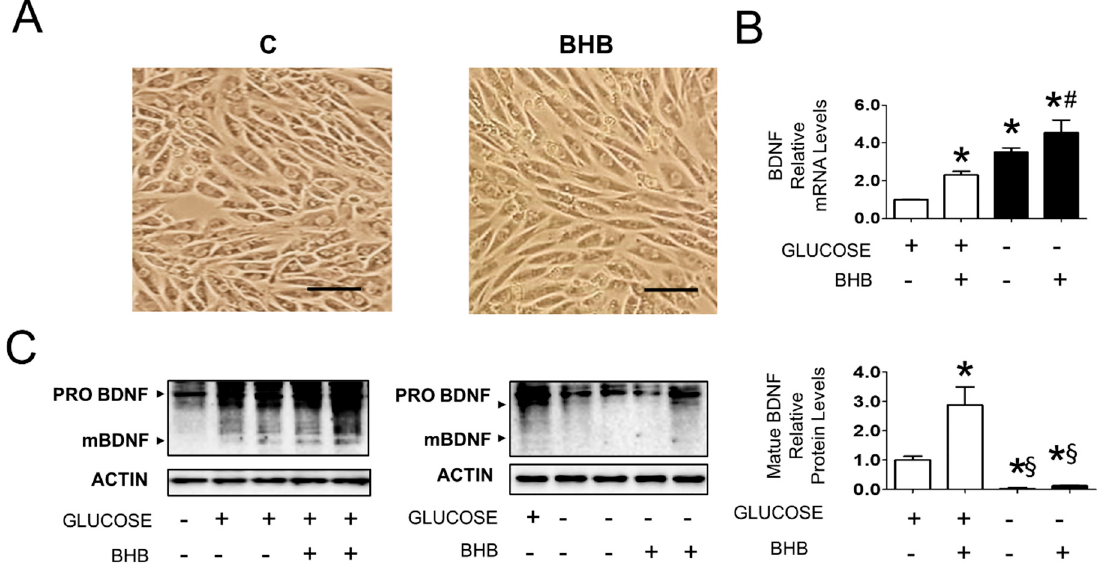
Figure 3. Effect of BHB on BDNF expression and maturation in L6 cells cultured in the presence and absence of 25 mM glucose ( N = 6). ( A ): Morphology of cells cultured in absence or presence of 8 mM BHB for 3 days. The images represent cells cultured in absence of glucose, similar results were observed in presence of glucose (not shown). Scale bar: 100 μ M. ( B ): BDNF mRNA levels in cells cultured in the presence and absence of 25 mM glucose and treated with solvent or 8 mM BHB. * p < 0.05 vs. control cells in presence of glucose, # p < 0.05 vs control cells in absence of glucose; ( C ): Protein levels of proBDNF and mBDNF in cells cultured in presence and absence of 25 mM glucose and treated with solvent or 8 mM BHB. * p < 0.05 vs control cells in presence of glucose, § p < 0.05 vs. cells in presence of glucose treated with solvent or 8 mM BHB. one way ANOVA was carried out followed by a Newman Keuls post-hoc test. Data are shown as means ± SEM.